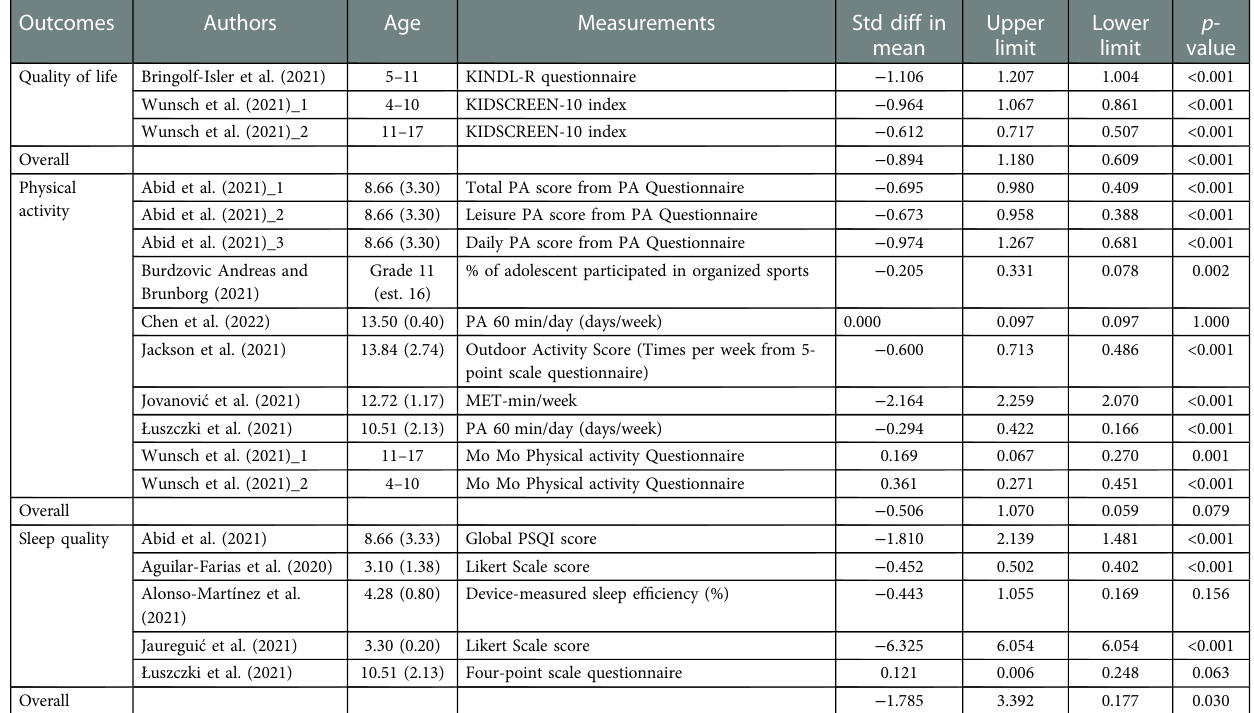
TABLE 3B Outcomes: the standardized mean difference in quality of life, PA and sleep